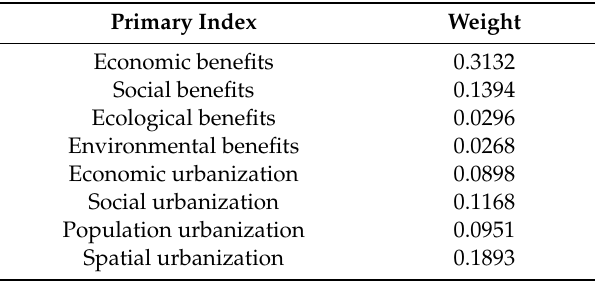
Table 4. Weights of primary indices.